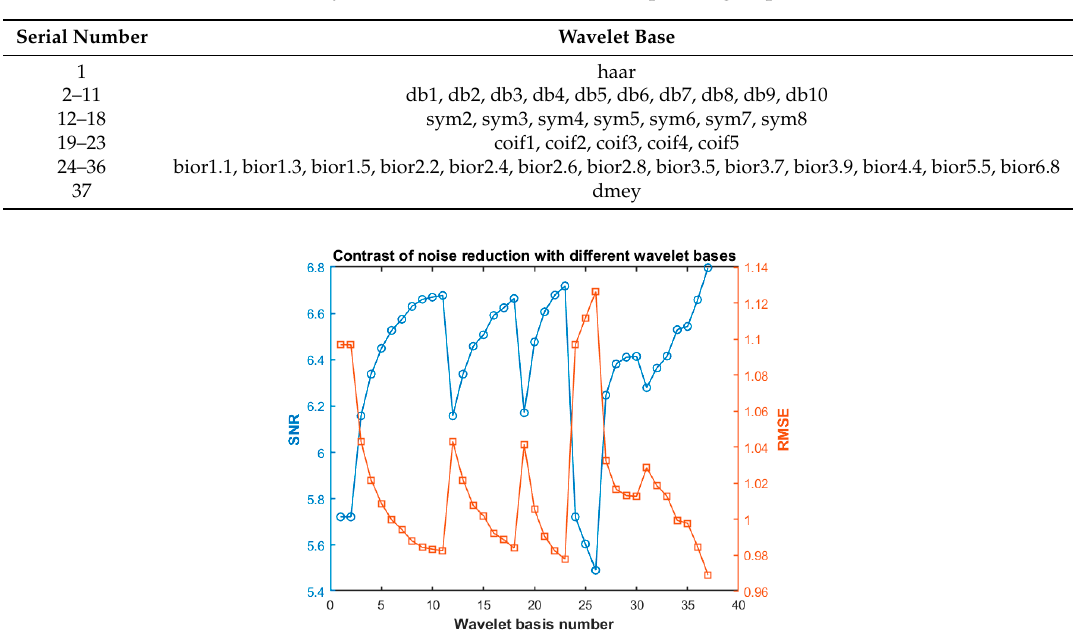
Figure 2. Bearing test stand.